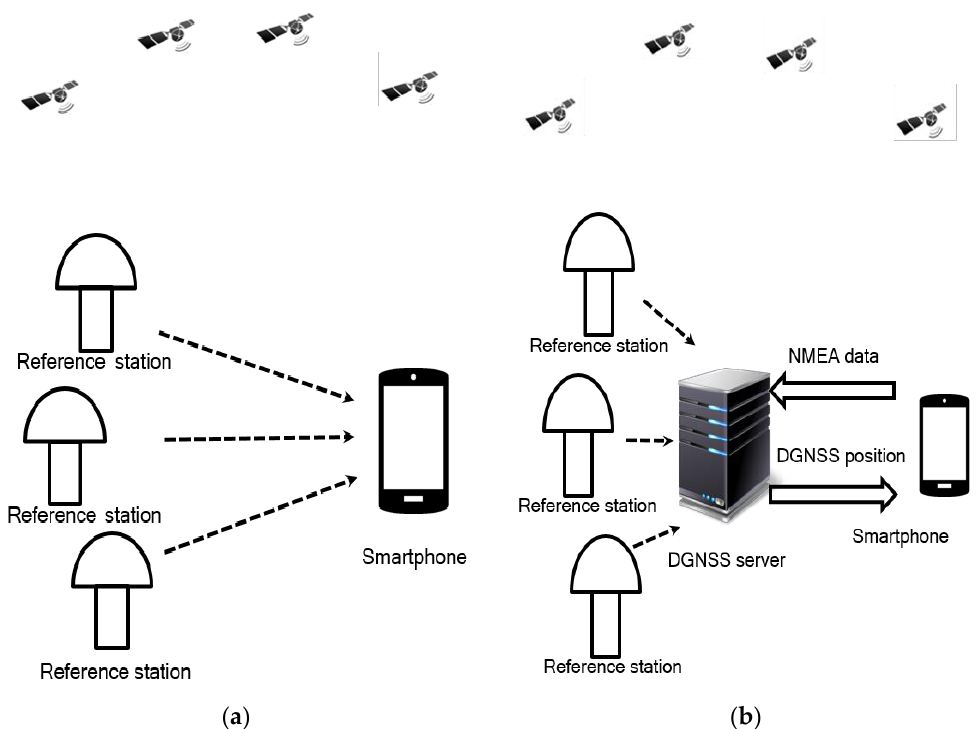
Figure 2. ( a ) use of a smartphone to calculate the DGNSS positions; ( b ) use of a server to calculate the DGNSS